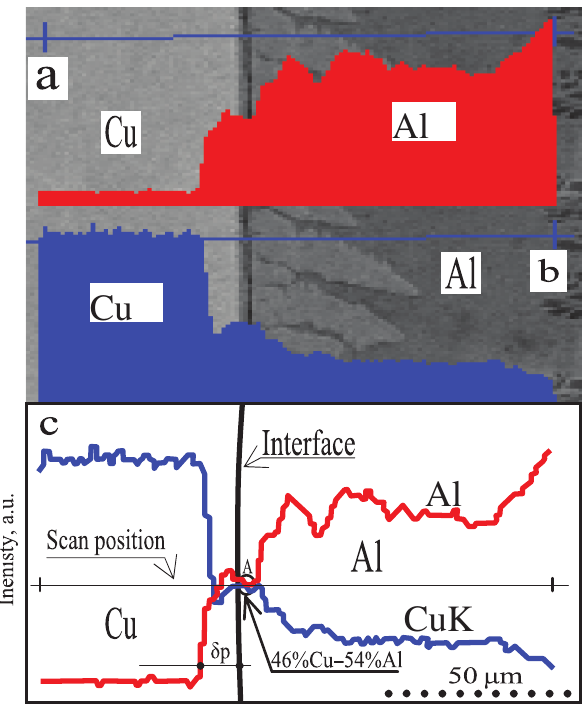
Figure 3: Distributions of Cu and Al on the two sides of Cu/Al bonding interface a-line scanning results of Al, b-line scanning results of Cu, c-distributions of Cu and Al, δ p-thickness of aluminum-containing layer in solid copper.